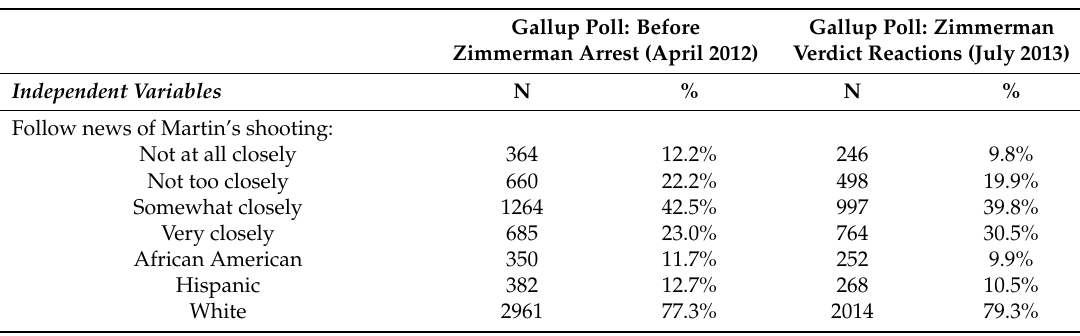
Table 1. Descriptive Statistics of the